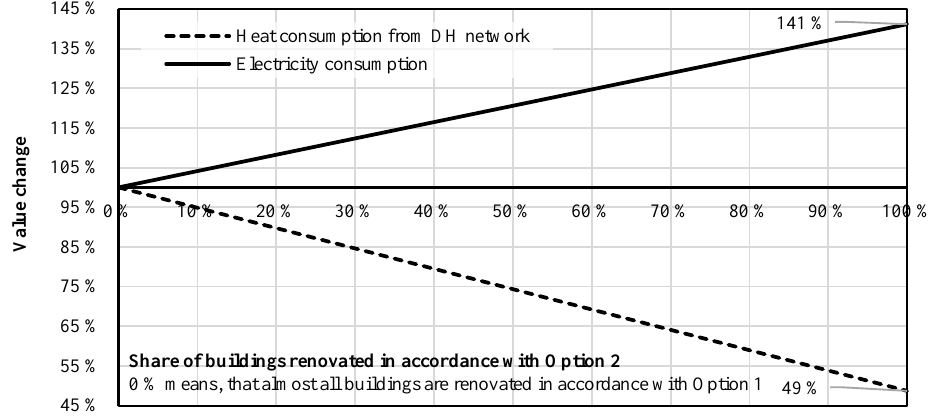
Fig. 2. Impact of an increased share of Option 2 building renovation solution implementation on heat consumption in the DH network and electric energy consumption. Fig. 2 shows that choosing Option 2 renovation solution will significantly decrease the